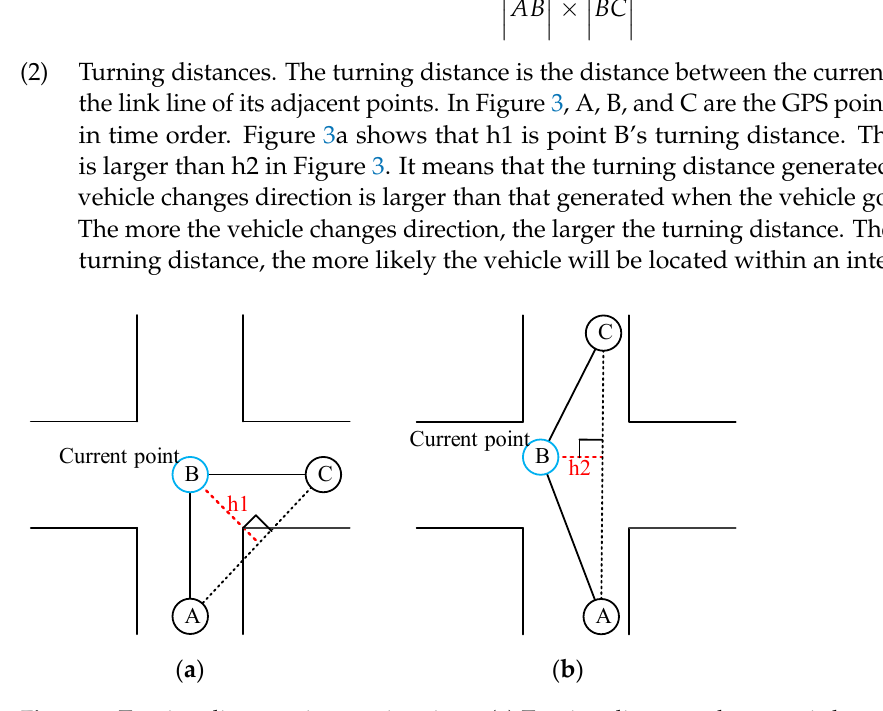
Figure 3. Turning distances in two situations: ( a ) Turning distance when a taxi changes direction; time